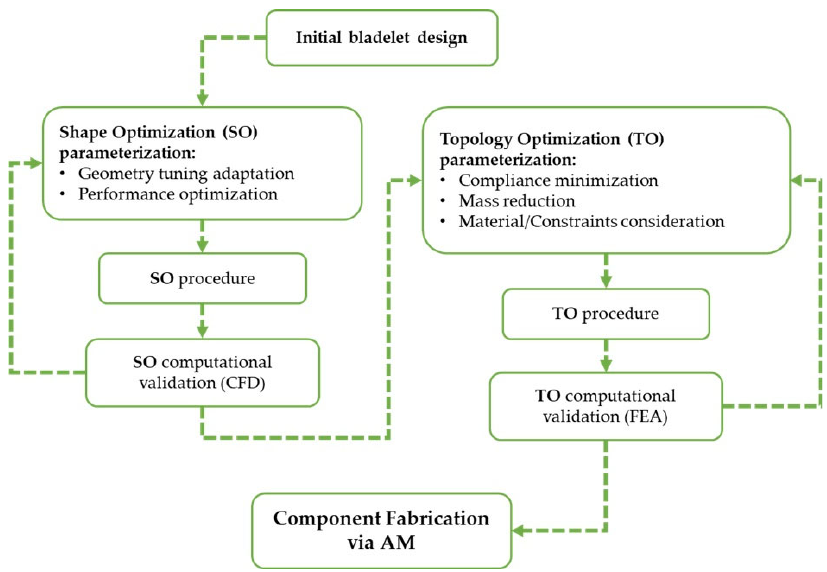
Figure 1. Bladelet optimization strategy overall schematic roadmap.